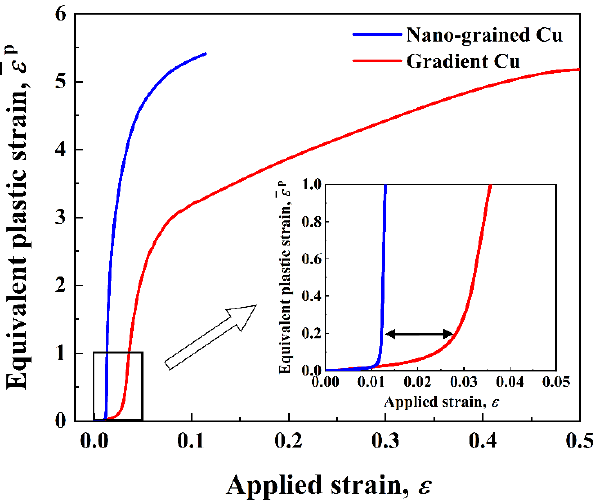
Figure 7. Evolution of the equivalent plastic strain ε p at the sites (indicated by the red crosses in Figure 5c,e) inside the shear bands of the NG and the gradient Cu.